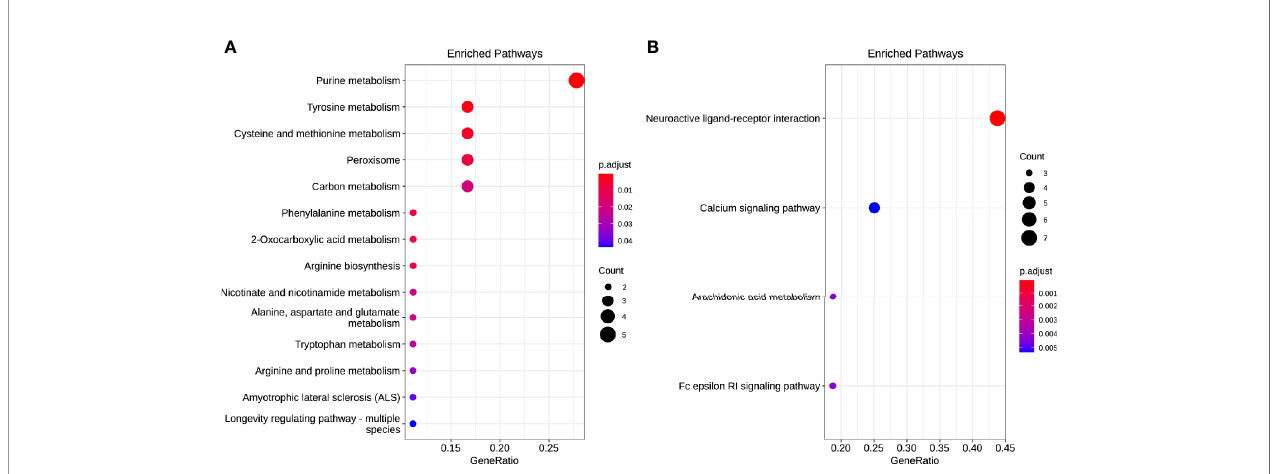
FIGURE 8 | The enrichment model of target molecules in the KEGG pathway [ (A) downregulated and (B)